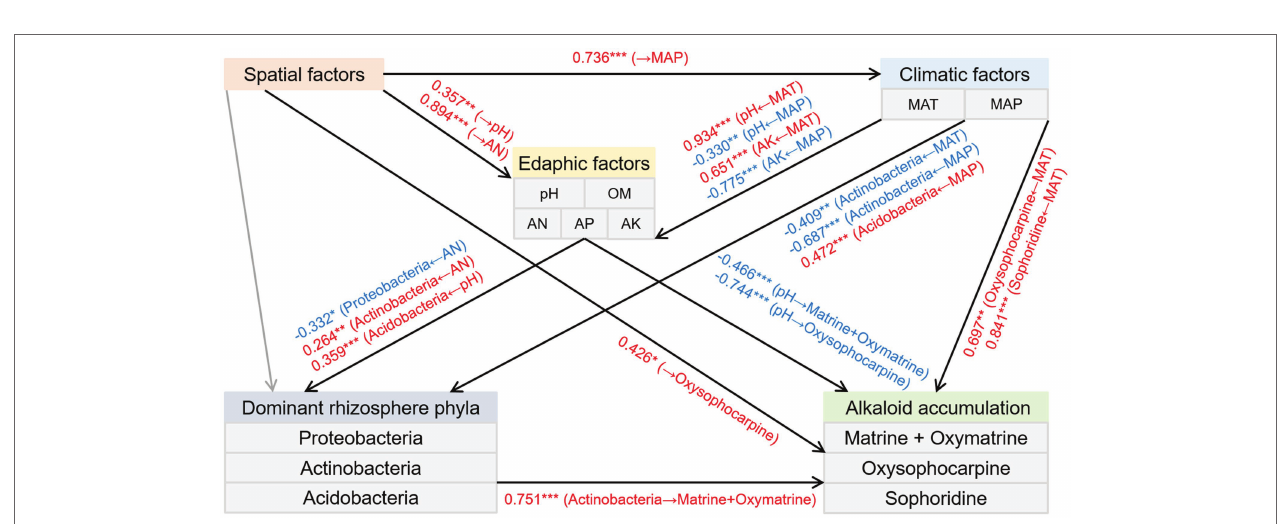
FIGURE 6 | Structural equation model depicting the direct and indirect effects of the spatial, climatic, and edaphic factors and the relative abundance of three preponderant rhizosphere phyla on the accumulation of alkaloids in the roots of S. flavescens ( P = 0.385; root-mean-squared error of approximation = 0.027; comparative fit index = 1.000). Black arrow lines: significant correlations; Gray arrow lines: correlations that are not significant; Red arrows: positive correlations; Blue arrows: negative correlations. Numbers between parameter boxes are indicative of the correlations. * P < 0.05; ** P < 0.01; *** P < 0.001. MAT: mean annual temperature; MAP: mean annual precipitation; OM: organic matter; AN: available N; AP: available P; AK: available